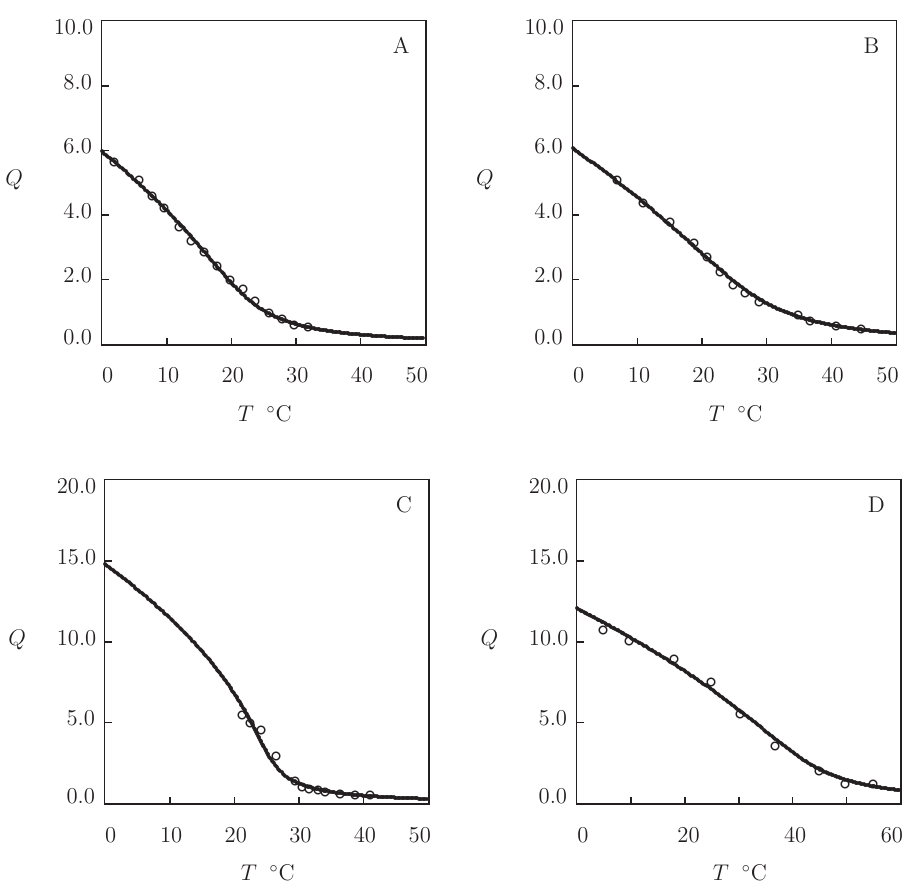
Figure 10. Degree of swelling Q versus temperature T . Circles: experimental data on PMEO 2 MA gels (( A ) macroscopic gel [101], ( B ) core–shell microgel with Au core and gel shell [102], ( C ) microgel particles [103], and ( D ) nanocomposite gel [104]). Solid lines: results of